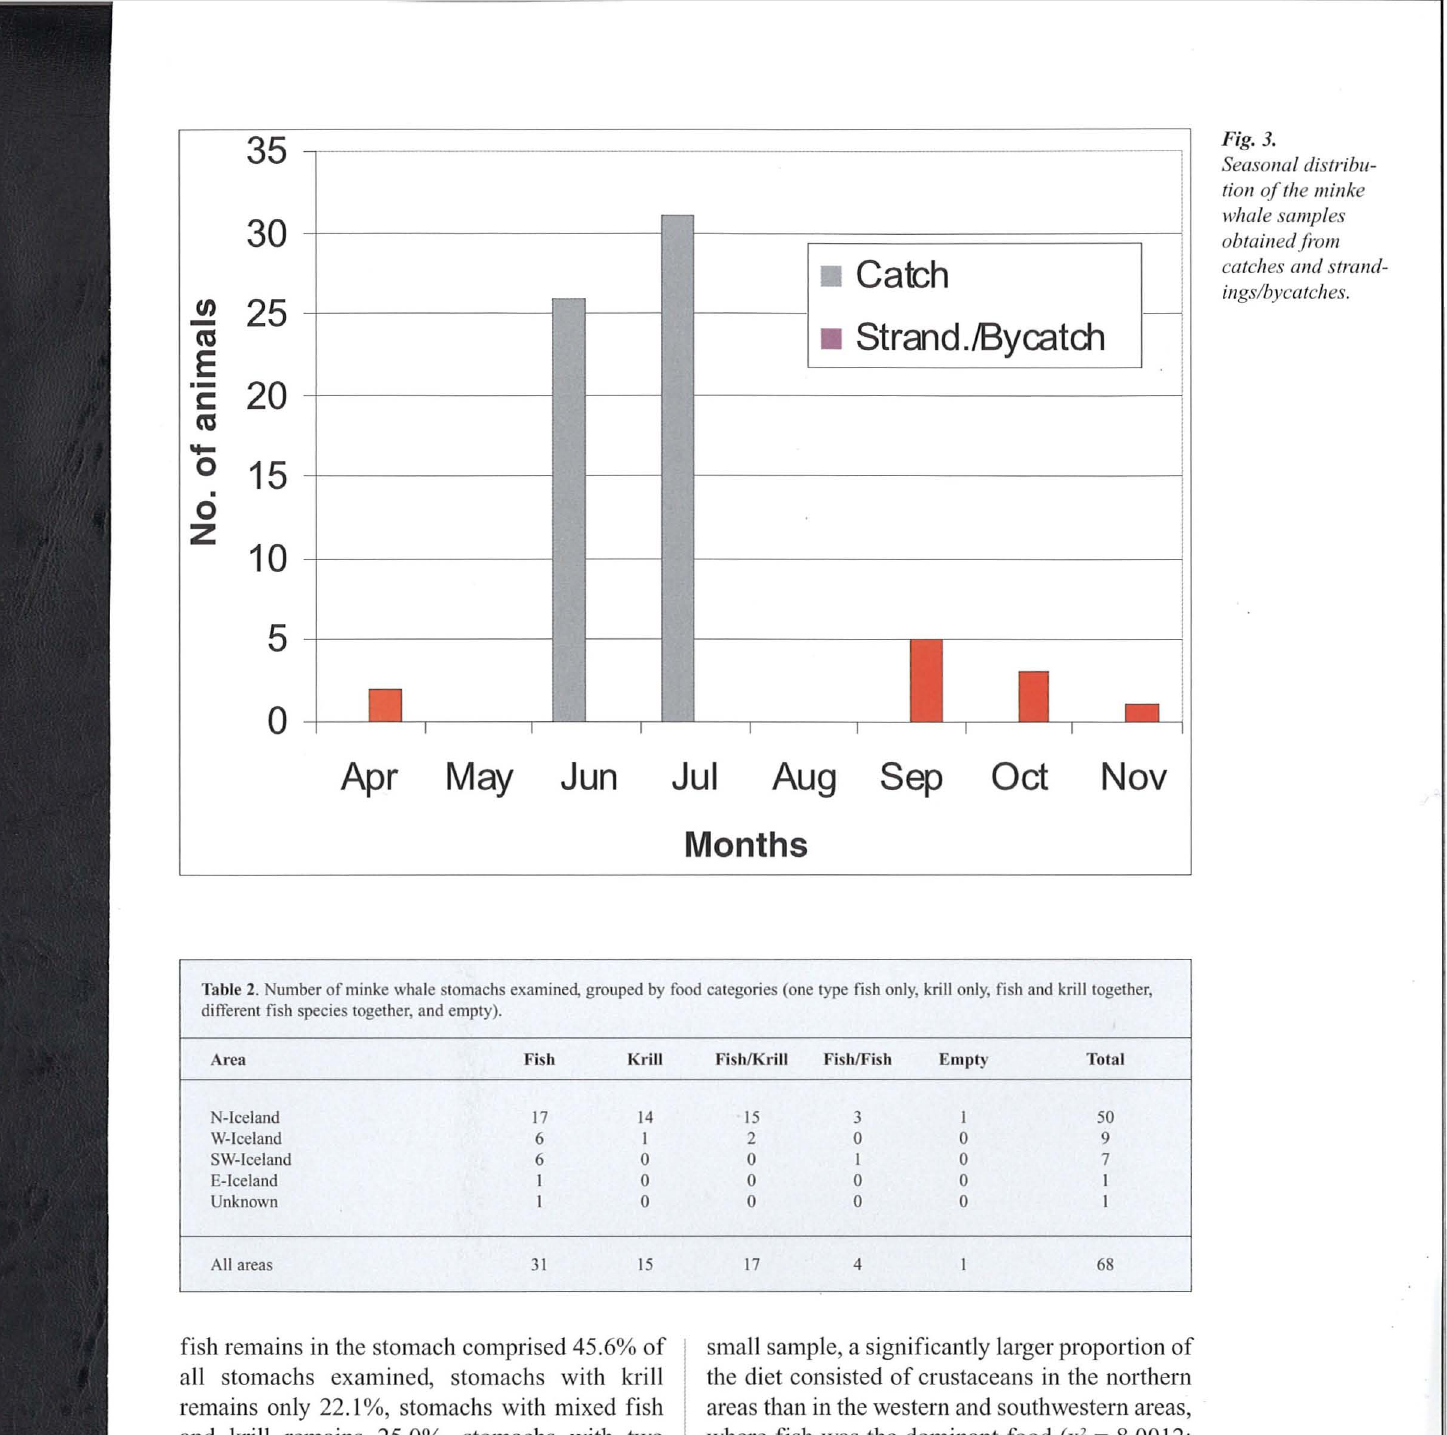
Fig. 3. Seasonal distribu tion of the lIIinke whale salllples obtained from catches and strand ings/bycatches